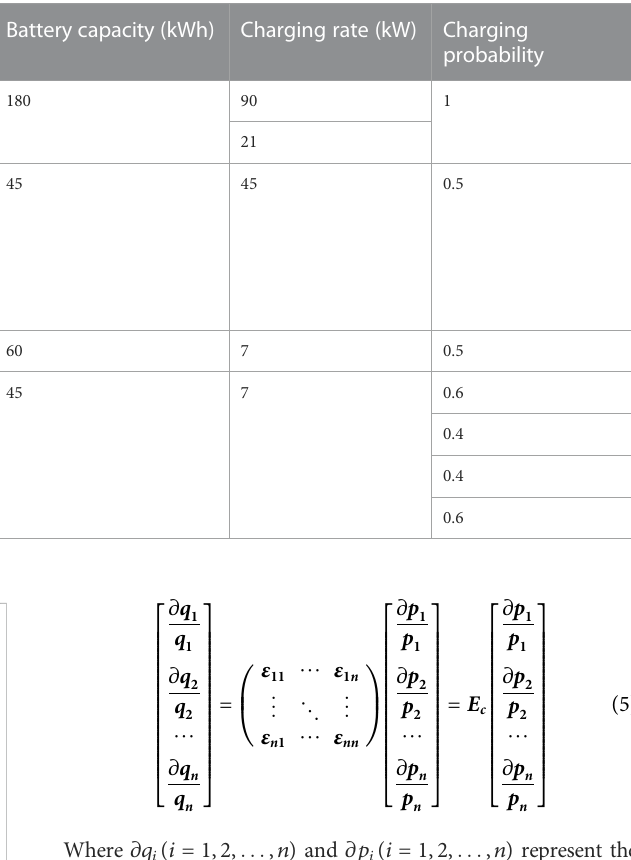
TABLE 1 The statistical data of EV charging events (Liu and Qi, 2014).